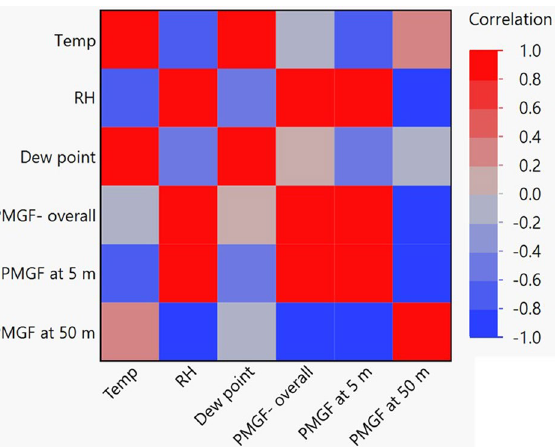
Figure 6. Correlation map showing the relationship between gene flow and the environmental parameters in field studies conducted across three environments: Environment 1, Jun–July, 2018; Environment 2, October– November, 2018; and Environment 3, August–September, 2019. Temp temperature, RH relative humidity (%), PMGF pollen mediated gene flow